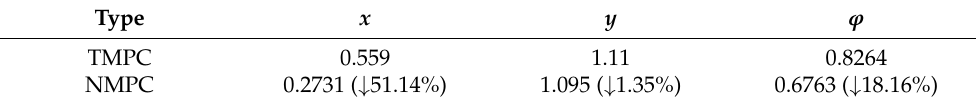
Table 2. The RMSE comparisons of the tracking errors of x , y , and ϕ under the